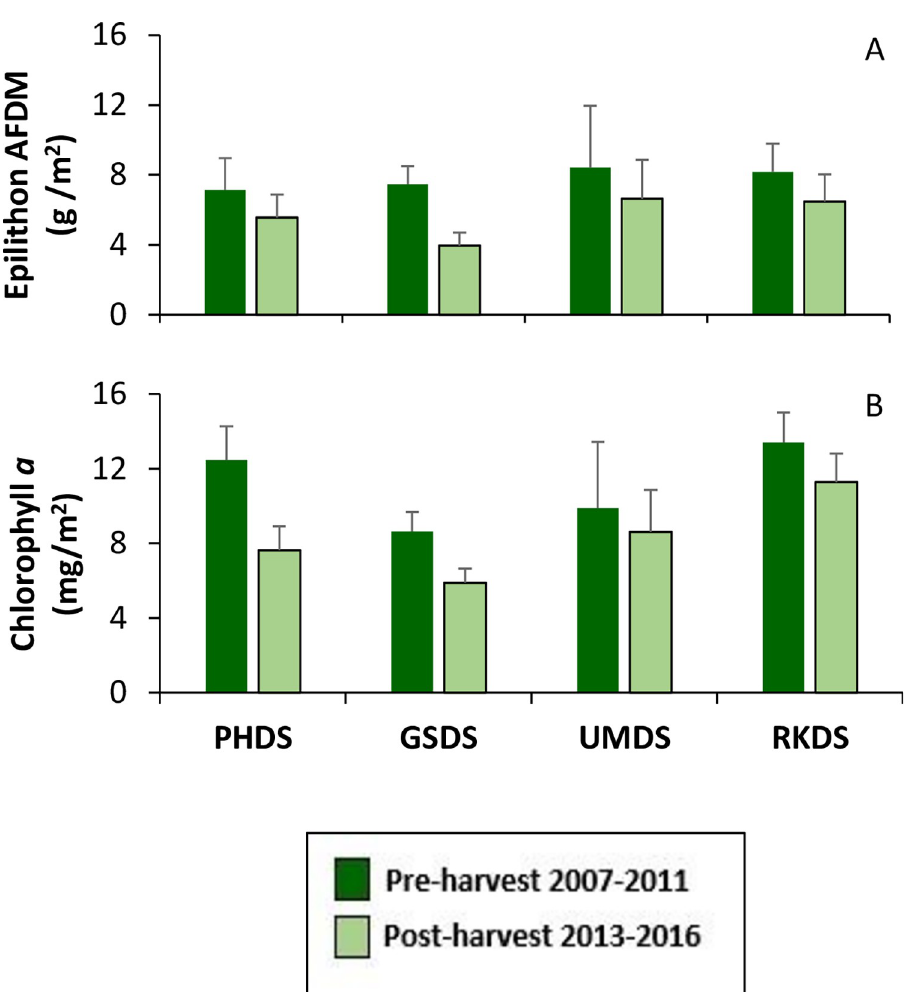
Fig 7. Average epilithon biomass and concentration of chlorophyll a at downstream sites during pre- and post- harvest periods. A) Epilithon biomass as ash free dry mass (AFDM); B) Chlorophyll a concentration. Bars show early summer average plus standard deviation. RKDS was the reference for the downstream sites. UMDS was downstream of variable buffer sites, PHDS was downstream of uniform buffer sites and GSDS had mixture of harvest groups